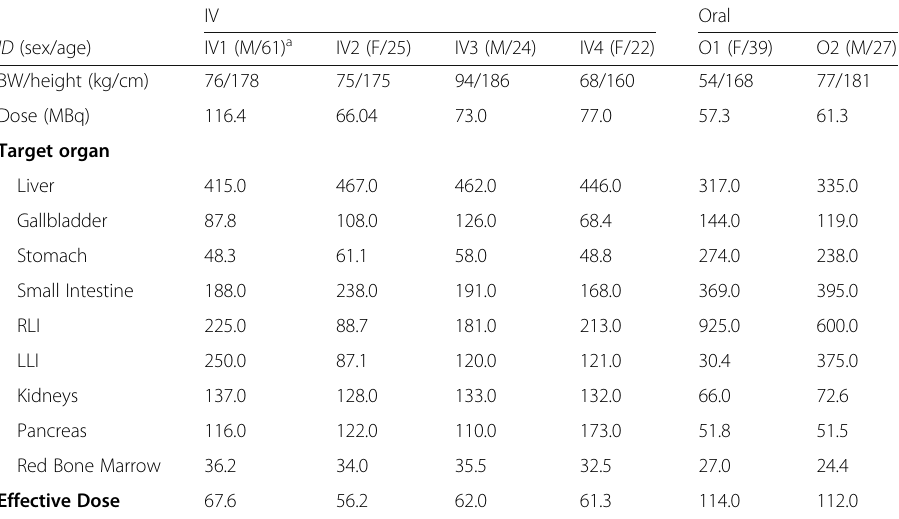
Table 1 Participant characteristics, gender-averaged absorbed dose estimates ( μ Gy/MBq), and effective dose ( μ Sv/MBq) for 64 Cu by intravenous (IV) and oral administration IV Oral